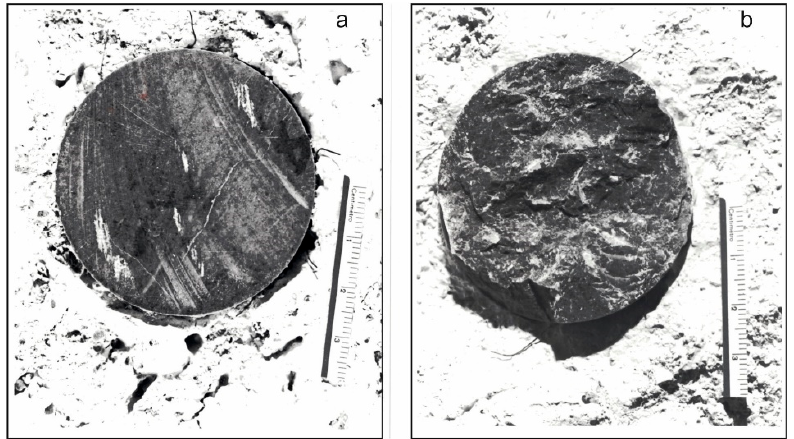
Figure 3. Photos of joint surfaces after the shear tests. ( a ) Artificial surface obtained by sawing; ( b ) natural surface obtained by the splitting method.